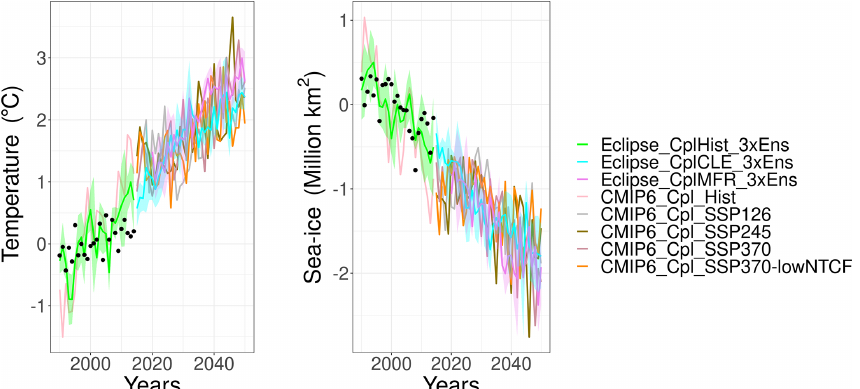
Figure 10. Arctic annual mean surface air temperature and sea-ice extent anomalies in 2015–2050 based on the 1990–2010 mean as calculated by the GISS-E2.1